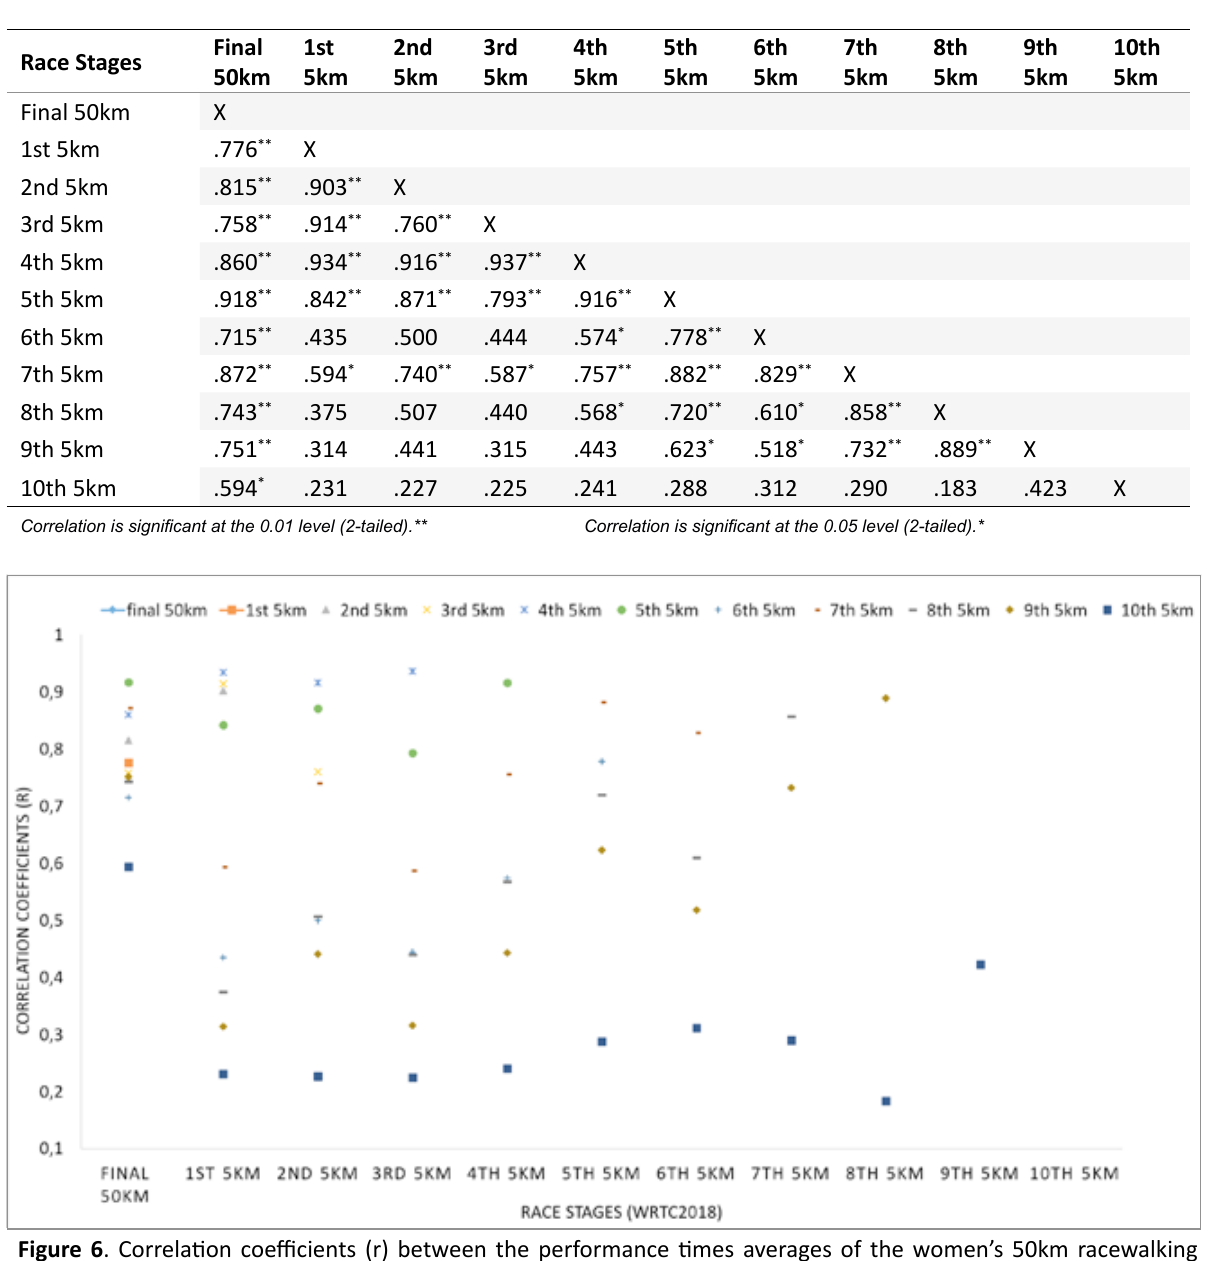
Table 6. Correlation coefficients (r) between the performance times averages of stages and with final 50km in WRTC2018.